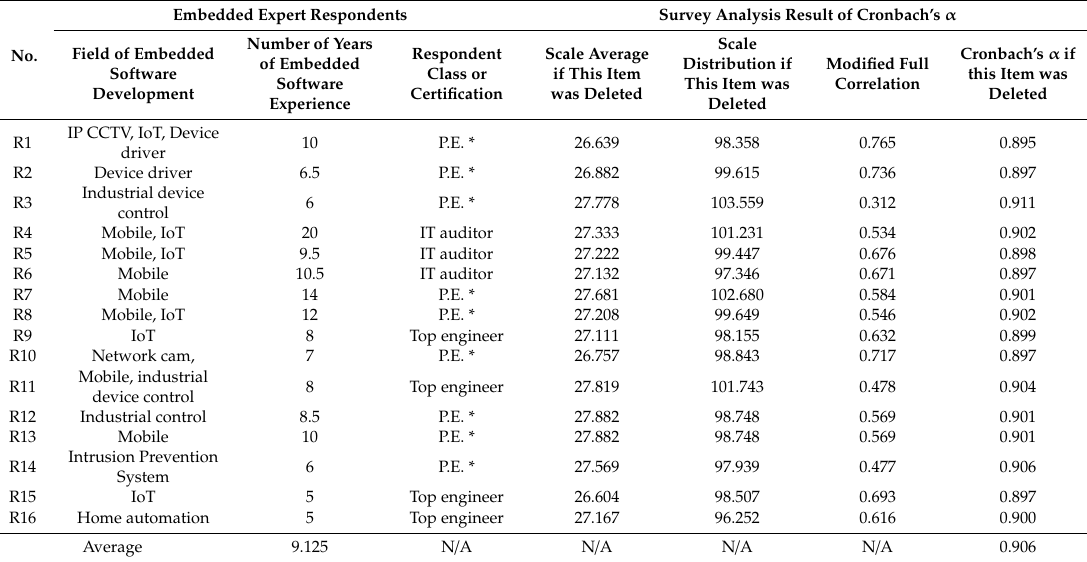
Table 9. Summary of Cronbach’s α analysis results for survey of embedded expert